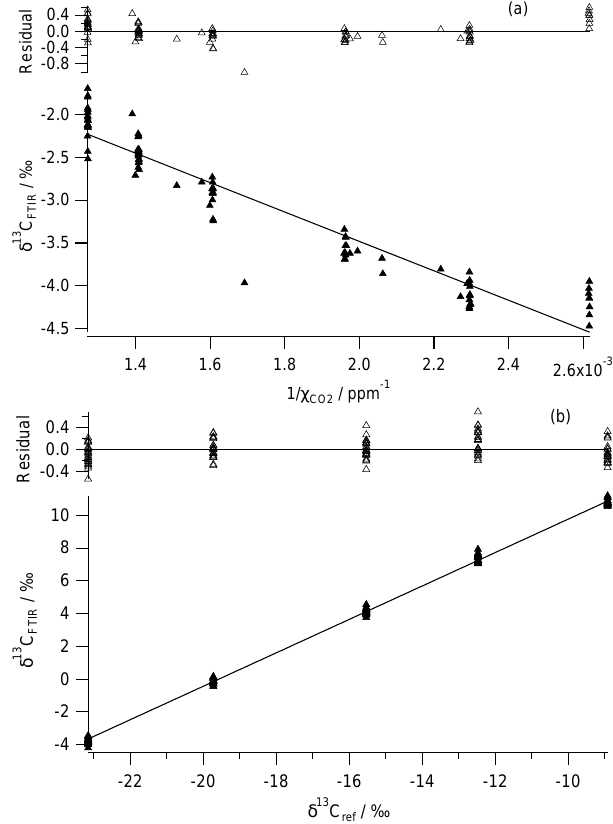
Fig. 7. (a) Empirical dependence of raw measured δ 13 C in CO 2 on the inverse CO 2 mole fraction, 1 /χ CO , following Eq. (14). Each 2 point is from a 1min average spectrum measured during the step- wise stripping sequence from 800 to 330µmol mol − 1 CO 2 . (b) Fit of Eq. (13) to δ 13 C measured by FTIR and corrected for CO 2 de- pendence (see text) against reference values for five reference tanks with CO 2 mole fractions 350–800µmol mol − 1 and δ 13 C values − 8 to − 23‰. Each point is from a 1-min average spectrum after filling the measurement cell with reference gas. From the fit α = 1 . 0199, equivalent to a scale shift of